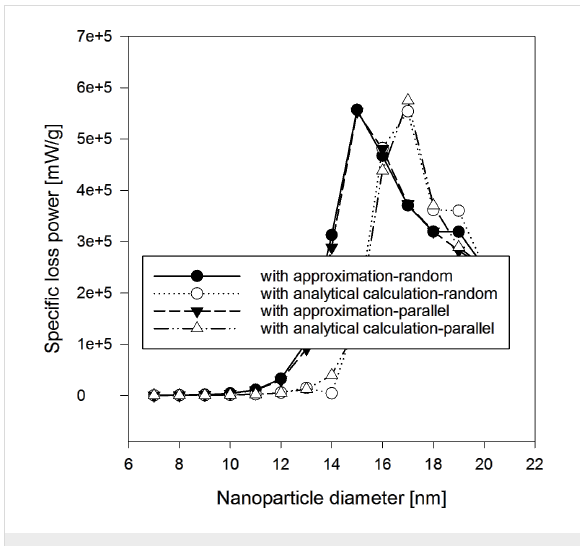
Figure 6: SLP vs diameter of the